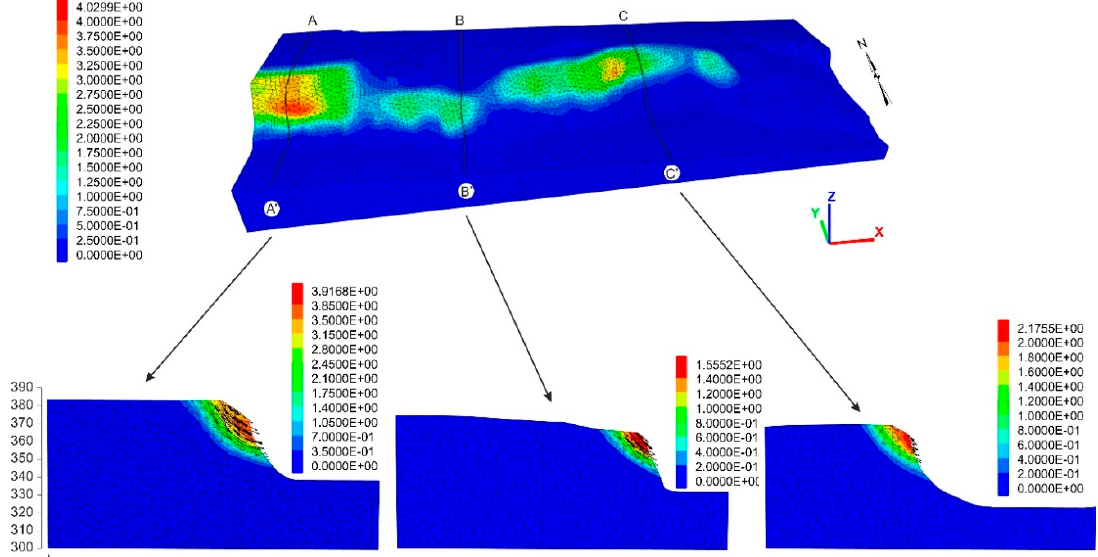
Figure 22. Contour displacements and displacement vectors (sections) of the pre-landslide model without discontinuities and with pore pressures.